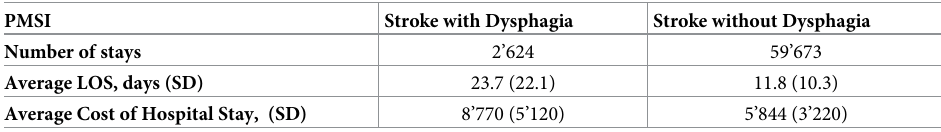
Table 3. Hospital LOS and Costs of Hospital stays for stroke with vs. without dysphagia in